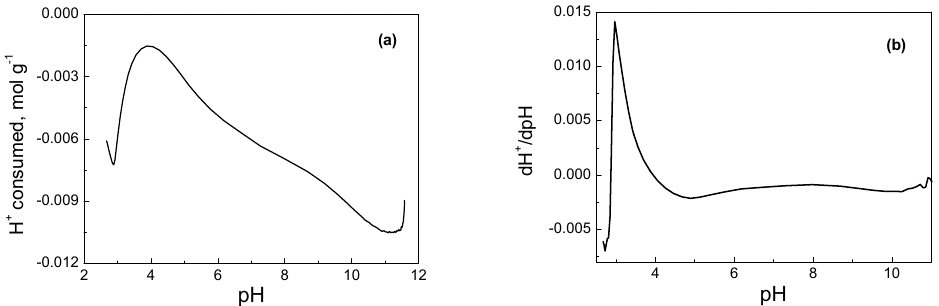
Figure 6. ( a ) H + consumed by the surface as a function of the solution pH; ( b ) the differential curve of the H + consumed with pH.